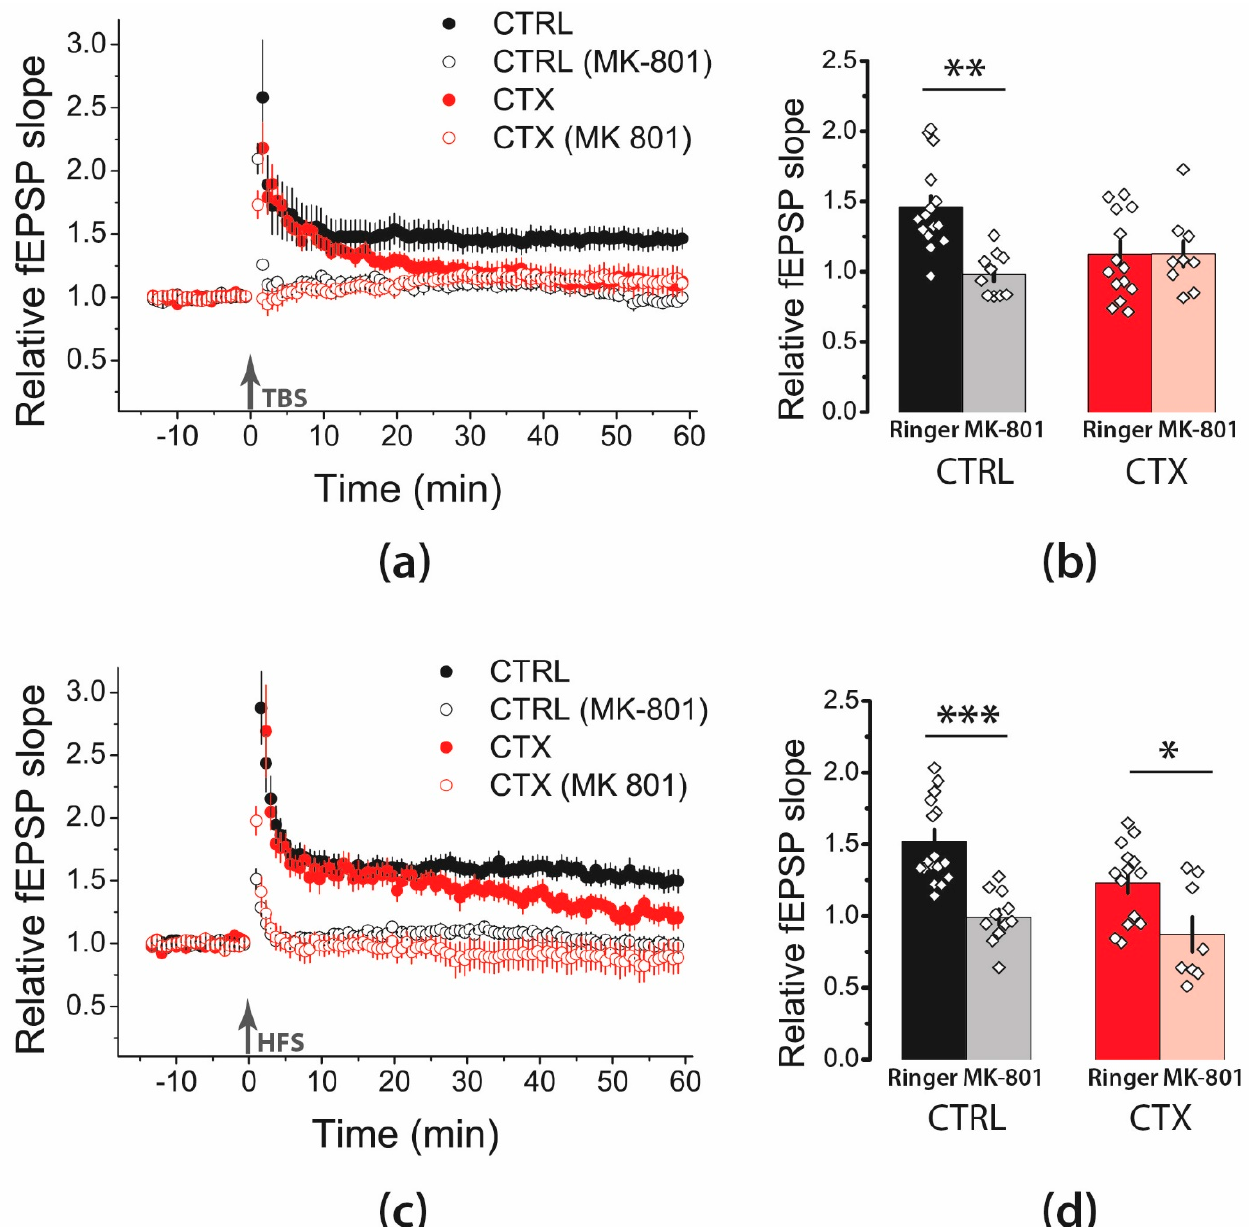
Figure 2. NMDAR-dependent mechanism of LTP induction is unaltered following administration of CTX. ( a , c ) Diagram showing changes in the value of the normalized slope of fEPSP in the control (CTRL) and CTX-treated groups (CTX) after TBS ( a ) and HFS ( c ). ( b , d ) Diagrams illustrating the magnitude of plasticity in the control and CTX groups in the presence of MK-801, after TBS ( b ) or HFS ( d ). Black arrow indicates the moment of LTP induction (TBS or HFS). Two-way ANOVA following Tukey post hoc tests were used. All the data are presented as mean ± standard error of the mean. * р < 0.05, ** р < 0.01, *** p < 0.001: A significant difference versus the control group (Tukey’s post hoc test).